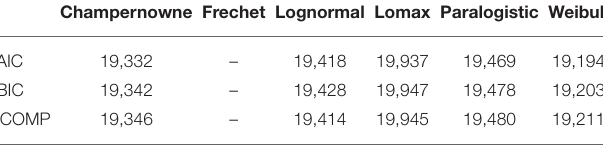
TABLE 12 | Simulation: Information criteria for Champernowne, Frechet, Lognormal, Lomax, Paralogistic, and Weibull models. Champernowne Frechet Lognormal Lomax Paralogistic